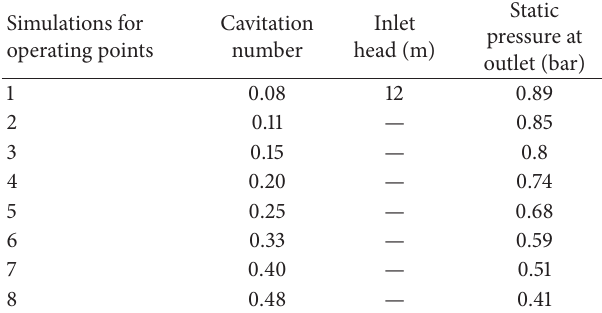
Table 4: Cavitation number and boundaries